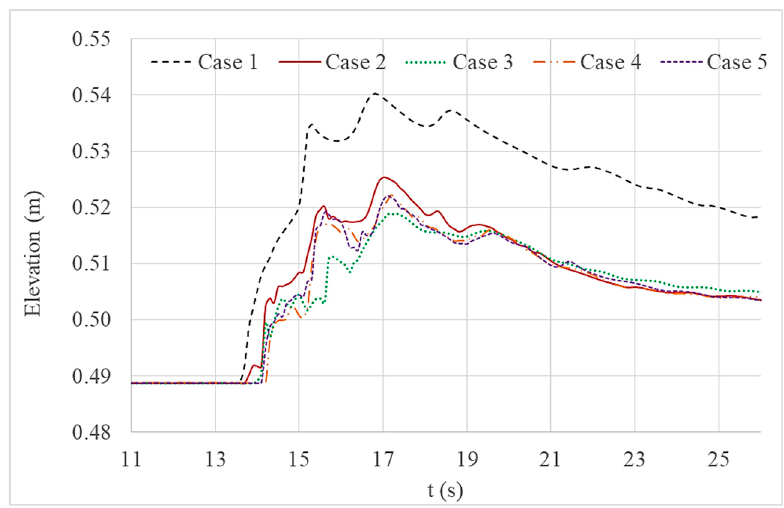
Figure 9. Comparison of water level variations at location D.